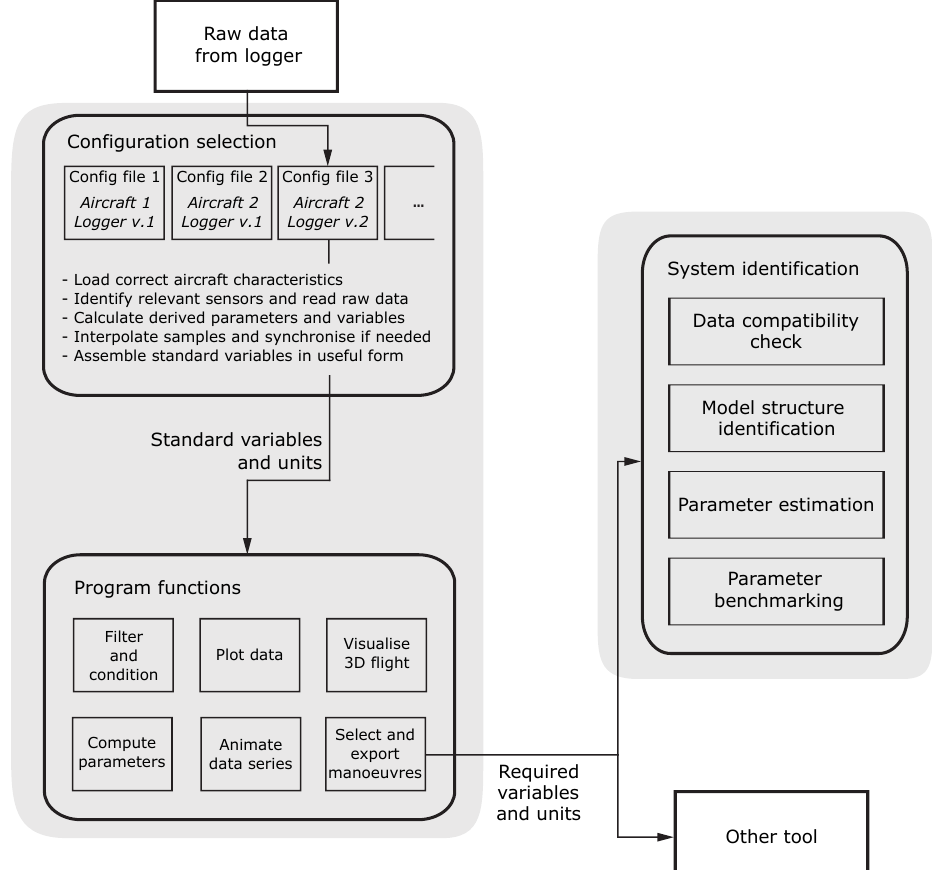
Figure 12. Simplified workflow describing post-flight data analysis using the ALAN software (v2.0, Linköping University, Linköping, Sweden), which currently covers the shaded areas.